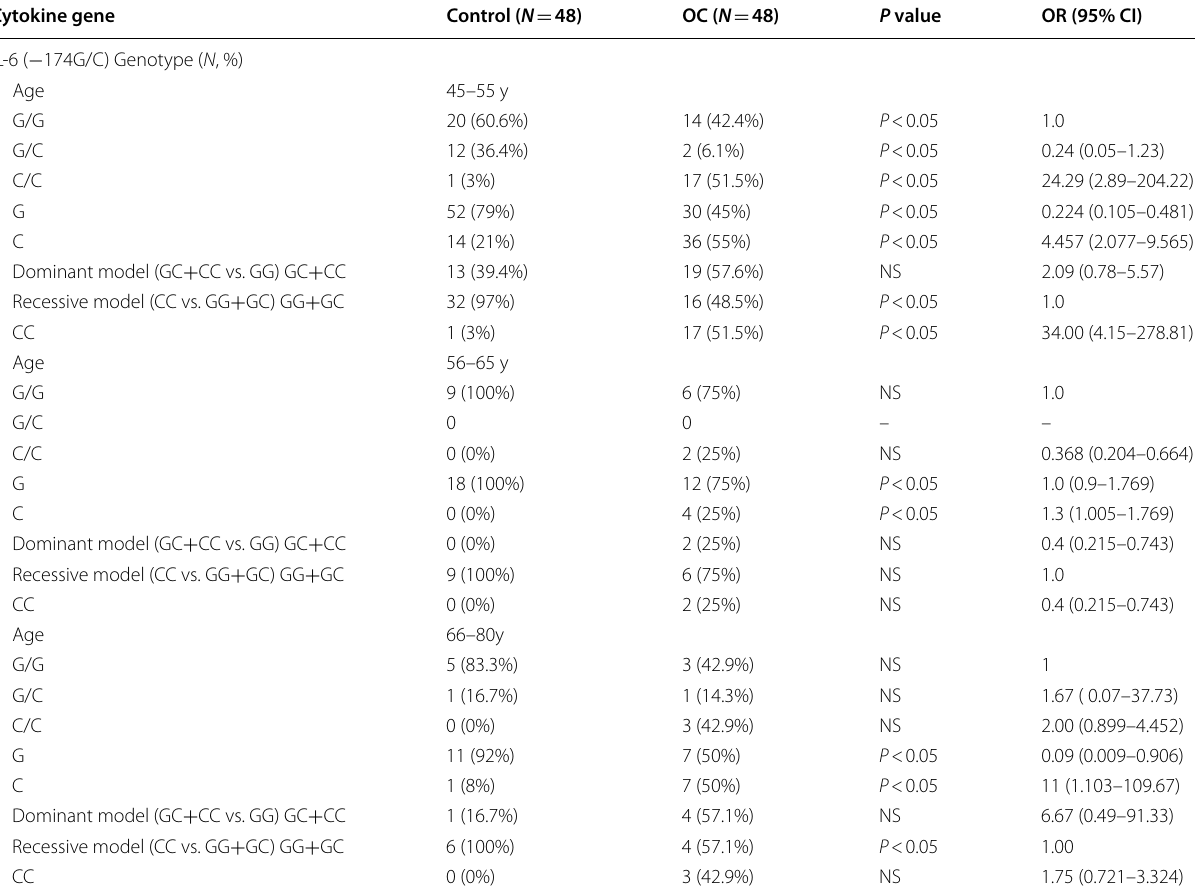
174G/C) in controls and patients with ovarian cancer according to ages −